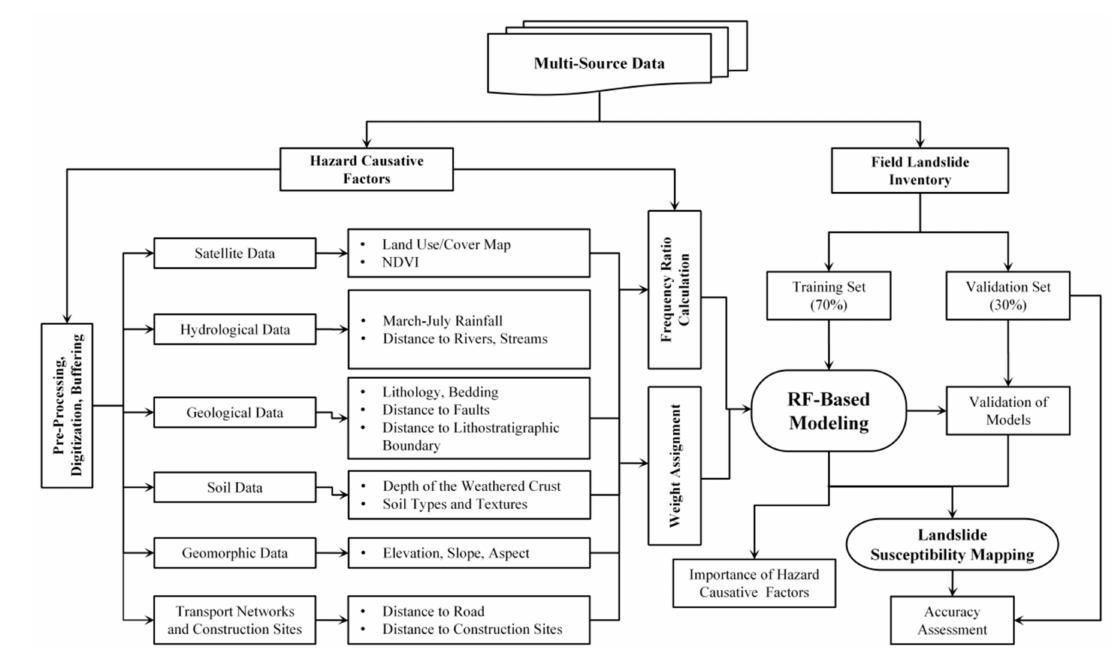
Figure 2. Methodological flowchart.